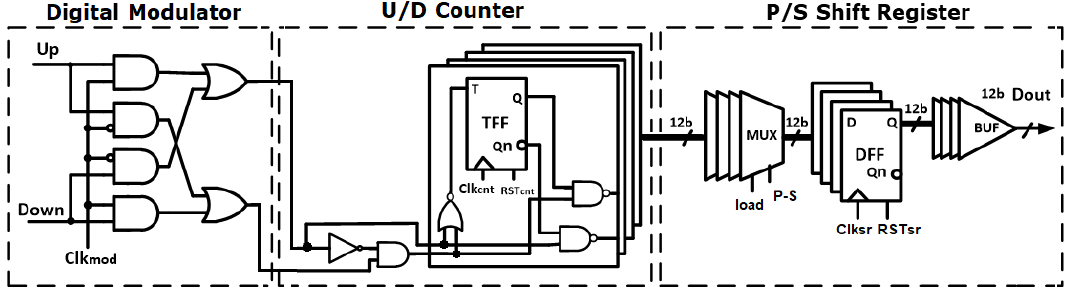
Figure 9. Schematic of the implemented decimator.